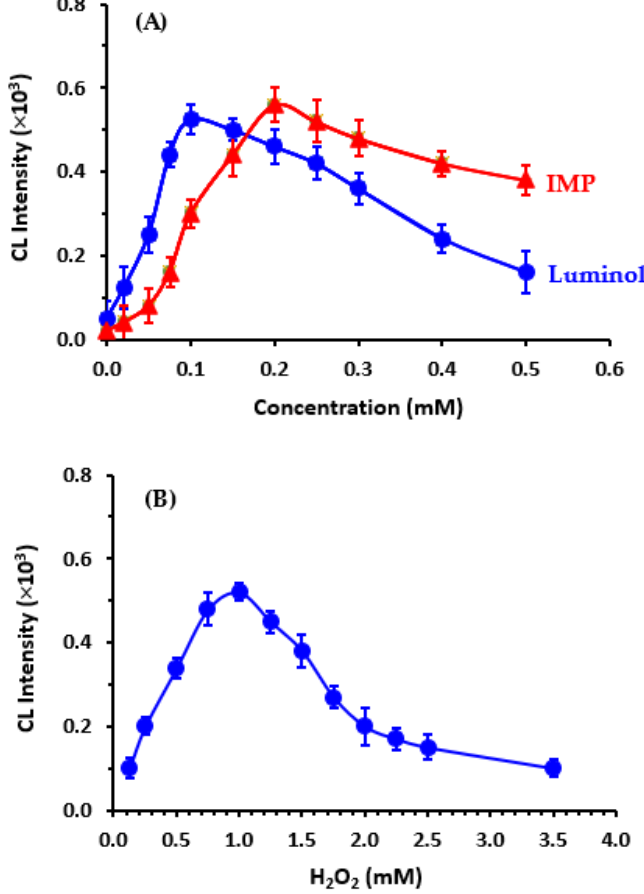
Figure 3. Effect of concentrations of luminol, IMP ( A ) and H 2 O 2 ( B ) on the CL intensity induced by HRP-luminol-H 2 O 2 -IMP reaction. The values are mean of 3 determinations ± SD. To study the impact of IMP concentration on the CL intensity, a similar set of trials were performed utilizing various concentrations (0–0.5 mM) of IMP and fixed concentrations of luminol and H 2 O 2 (0.1 and 1 mM, respectively). The results (Figure 3A) demonstrated that the maximum CL intensity was obtained when the concentration of IMP was 0.2